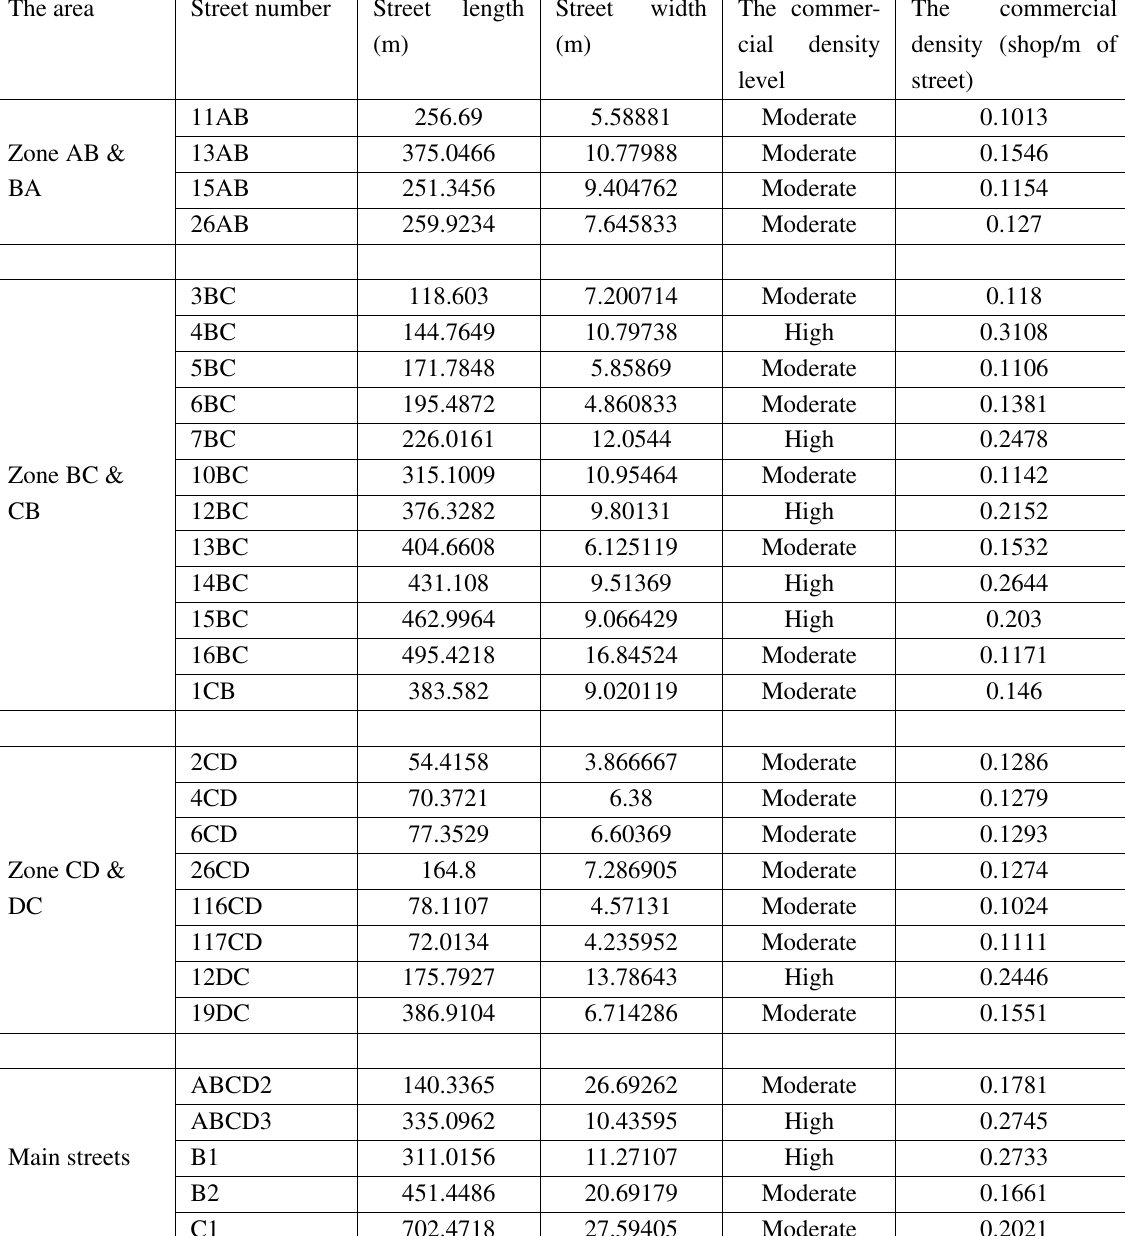
Table 2. The crowded streets’ characteristics and